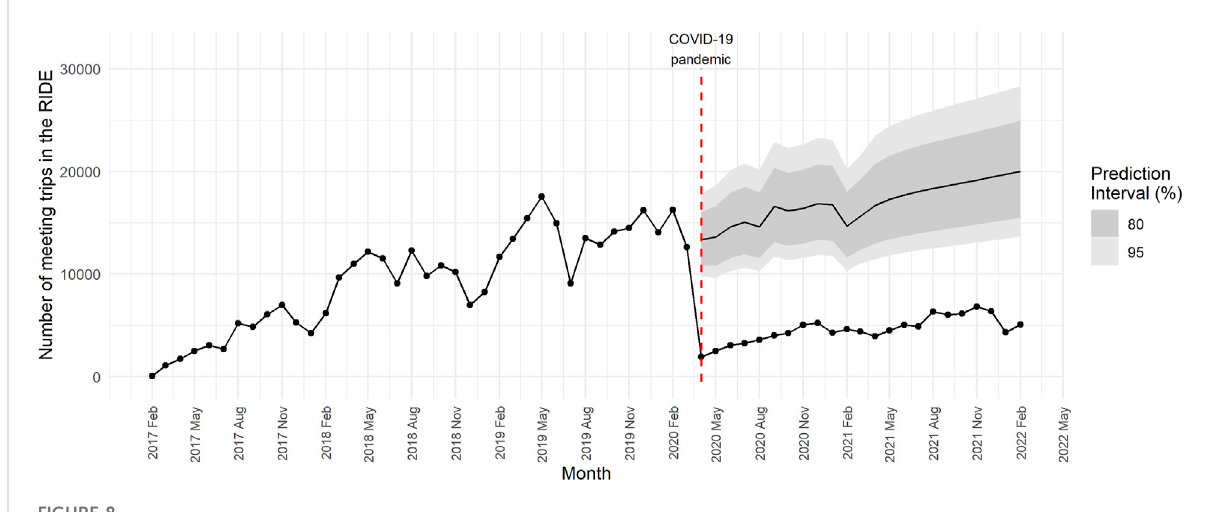
FIGURE 8 Counterfactual scenario of the number of meeting trips when there was no COVID-19